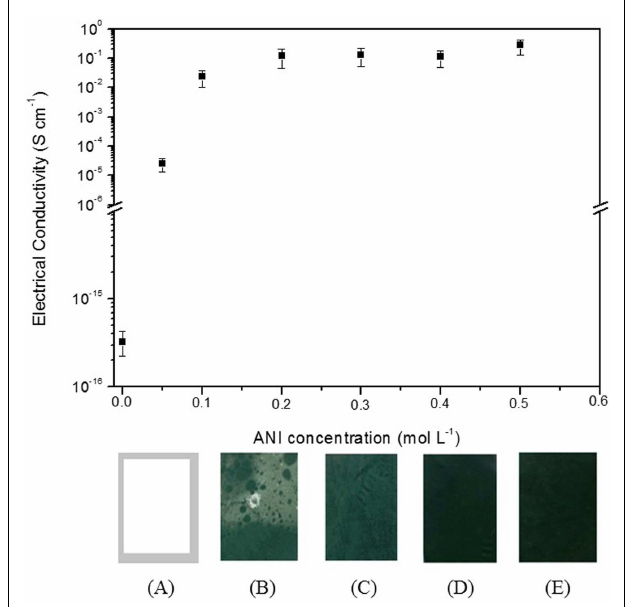
FIGURE 1 | Electrical conductivity of PVDF/PANI mats as function of aniline concentration in the polymerization medium . Digital photographs of (A) PVDF and PVDF/PANI mats with monomer concentration of (B) 0.05molL − 1 , (C) 0.1molL − 1 , (D) 0.3molL − 1 , and (E) 0.5molL − 1 .